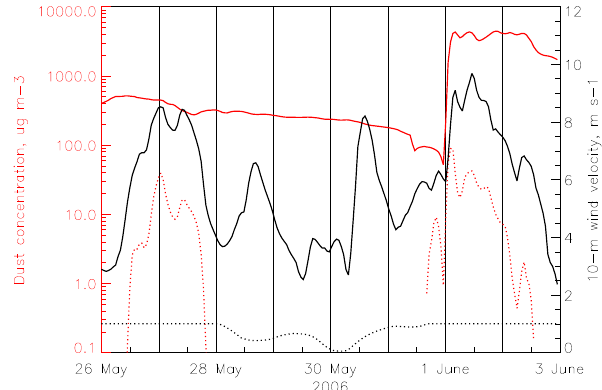
Fig. 8. Mean values along the trajectories. According to the left axis: dust concentration (solid red line,µgm − 3 ), dust emission (dotted red line, µgm − 2 s − 1 ); according to the right axis: 10-m wind velocity (solid black line, ms − 1 ), Land-Sea-Mask (dotted black